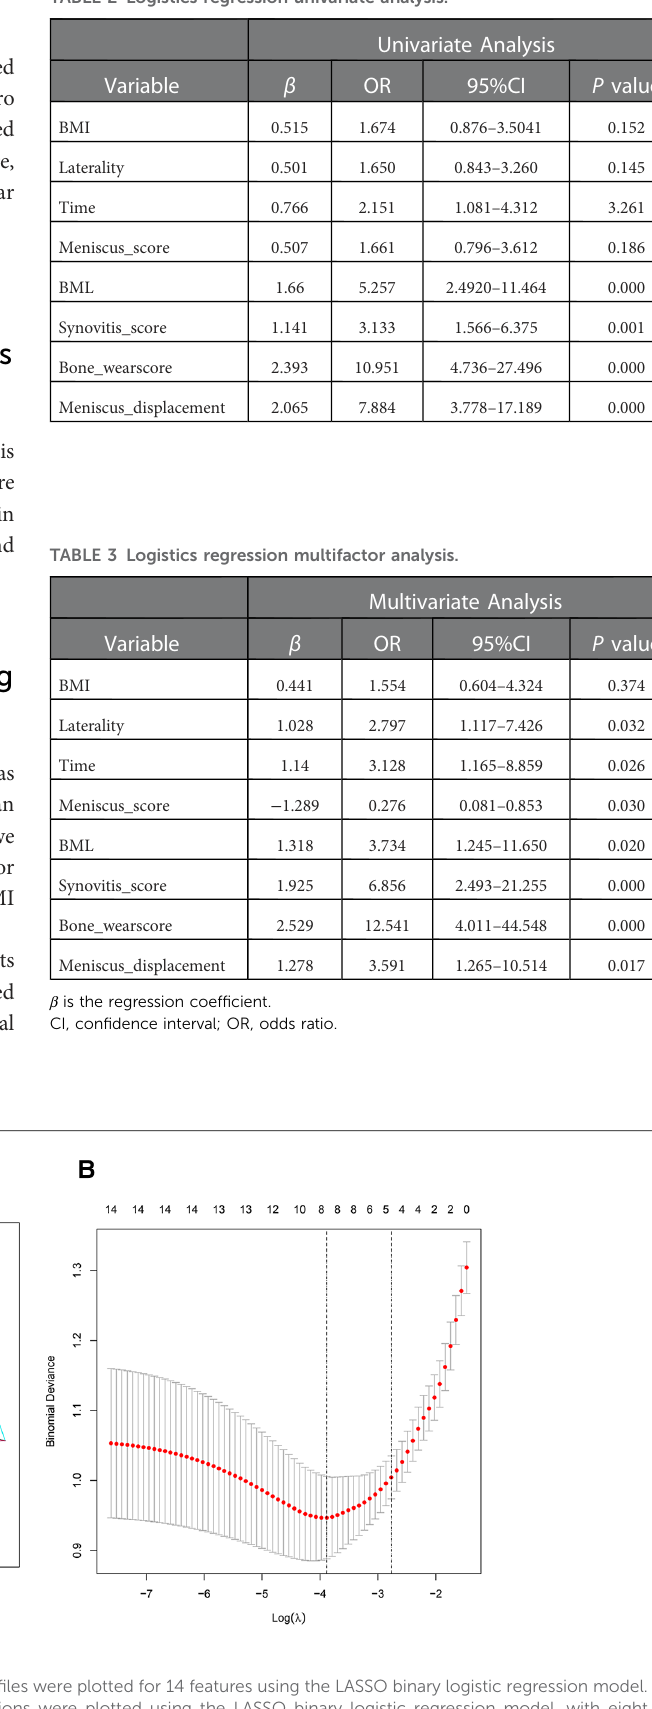
TABLE 2 Logistics regression univariate